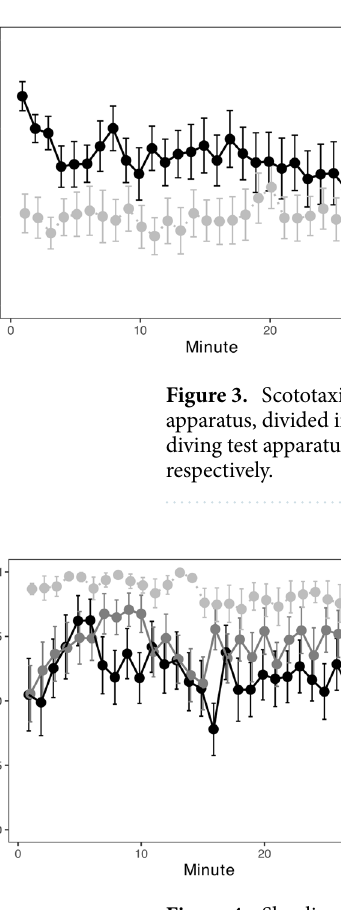
Figure 4. Shoaling test. ( a ) time spent by subjects in the sector close to the shoal of conspecifics in the shoaling test, divided in 1-min bins; ( b ) number of switchings between the 2 choice sectors performed by subjects in the shoaling test, divided in 1-min bins. Data points and error bars represents means and standard errors,